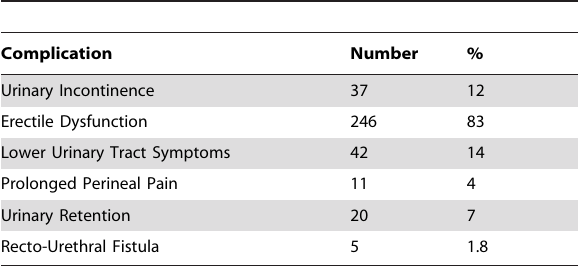
Table 2. Post-SCT complications and the number of patients affected by each